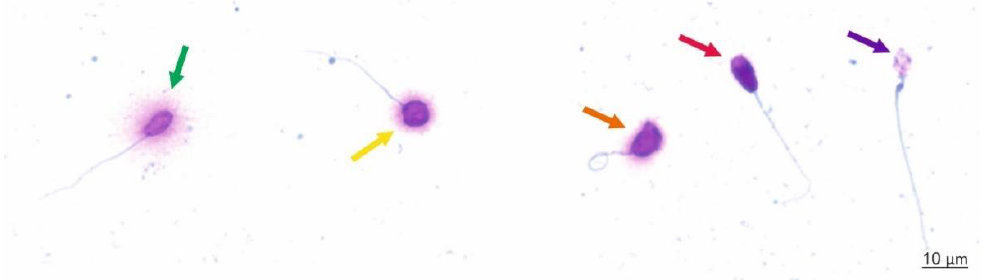
Figure 2. Micrograph of sperm chromatin dispersion test (SCD) results obtained by light microscopy. Sperm cells with large halos (green arrow) and medium-sized halos (yellow arrow) have normal integrity of nuclear DNA, and sperm cells with small halos (orange arrow), without halos (red arrow) or without halos and degraded chromatin (violet arrow) have fragmented nuclear DNA.